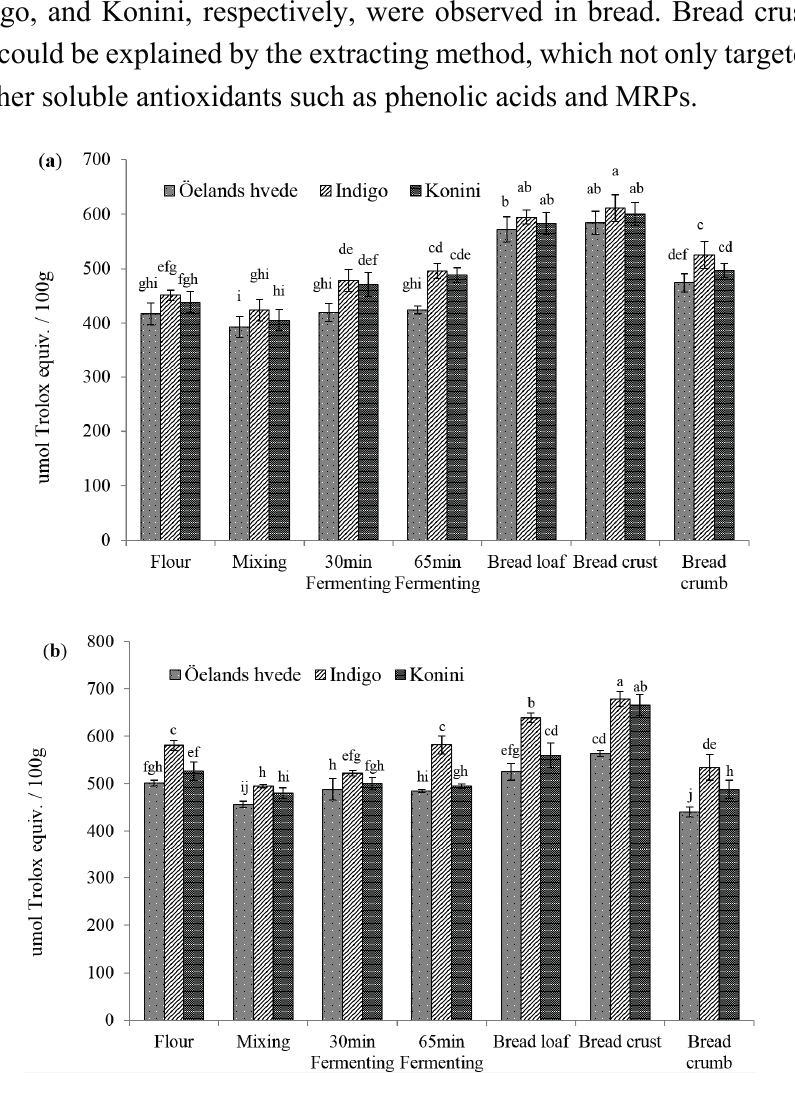
Figure 5. DPPH radical scavenging capacity ( a ) and ABTS radical cation decolorization activity ( b ) of anthocyanin extracts. Columns labeled with different letters are significantly different ( p <